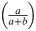
Comparison of empirical data (a) from chromosome 1A of a Cadenza X Avalon F2 mapping population with 96 individuals to simulated data (b–d).The simulations each have 96 individuals and were produced using the marker distribution from the empirical data. The y-axis shows the segregation ratio of homozygous genotypes, shown here as a proportion of the total number of homozygous genotypes (aa+b). The black horizontal line indicates an even 1:1 ratio of homozygous genotypes. Included are simulations of both F2 (b, c) and F6 (d, e) single seed descent populations for comparison, as well as simulations exhibiting the least (b, d) and the most (c, e) amount of segregation distortion out of 1000 simulations. None of the simulations have any selection pressure applied, so these plots indicate the effect of sampling error on segregation. Sig. = significance threshold (chi-square test).